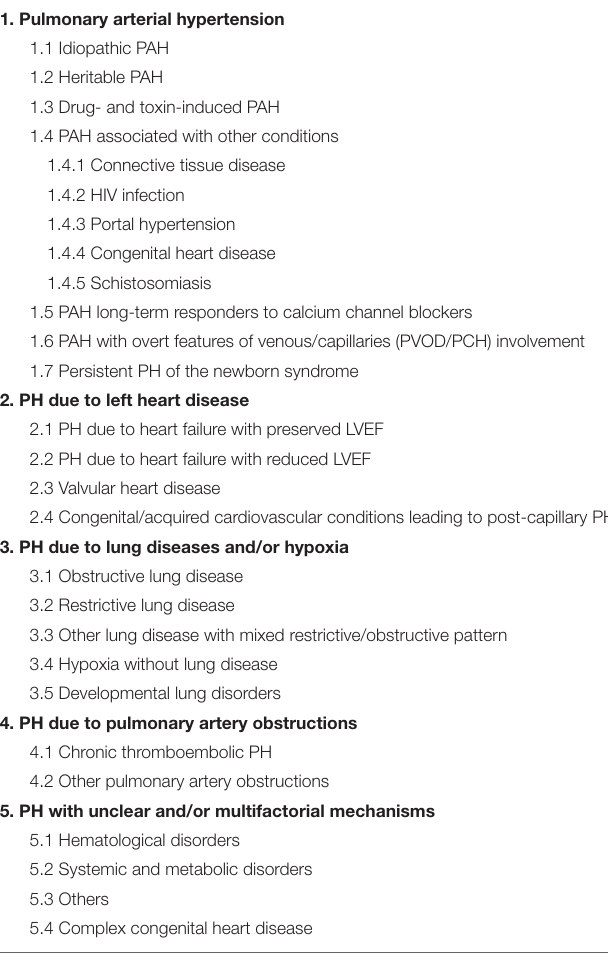
TABLE 1 | Updated clinical classification of pulmonary